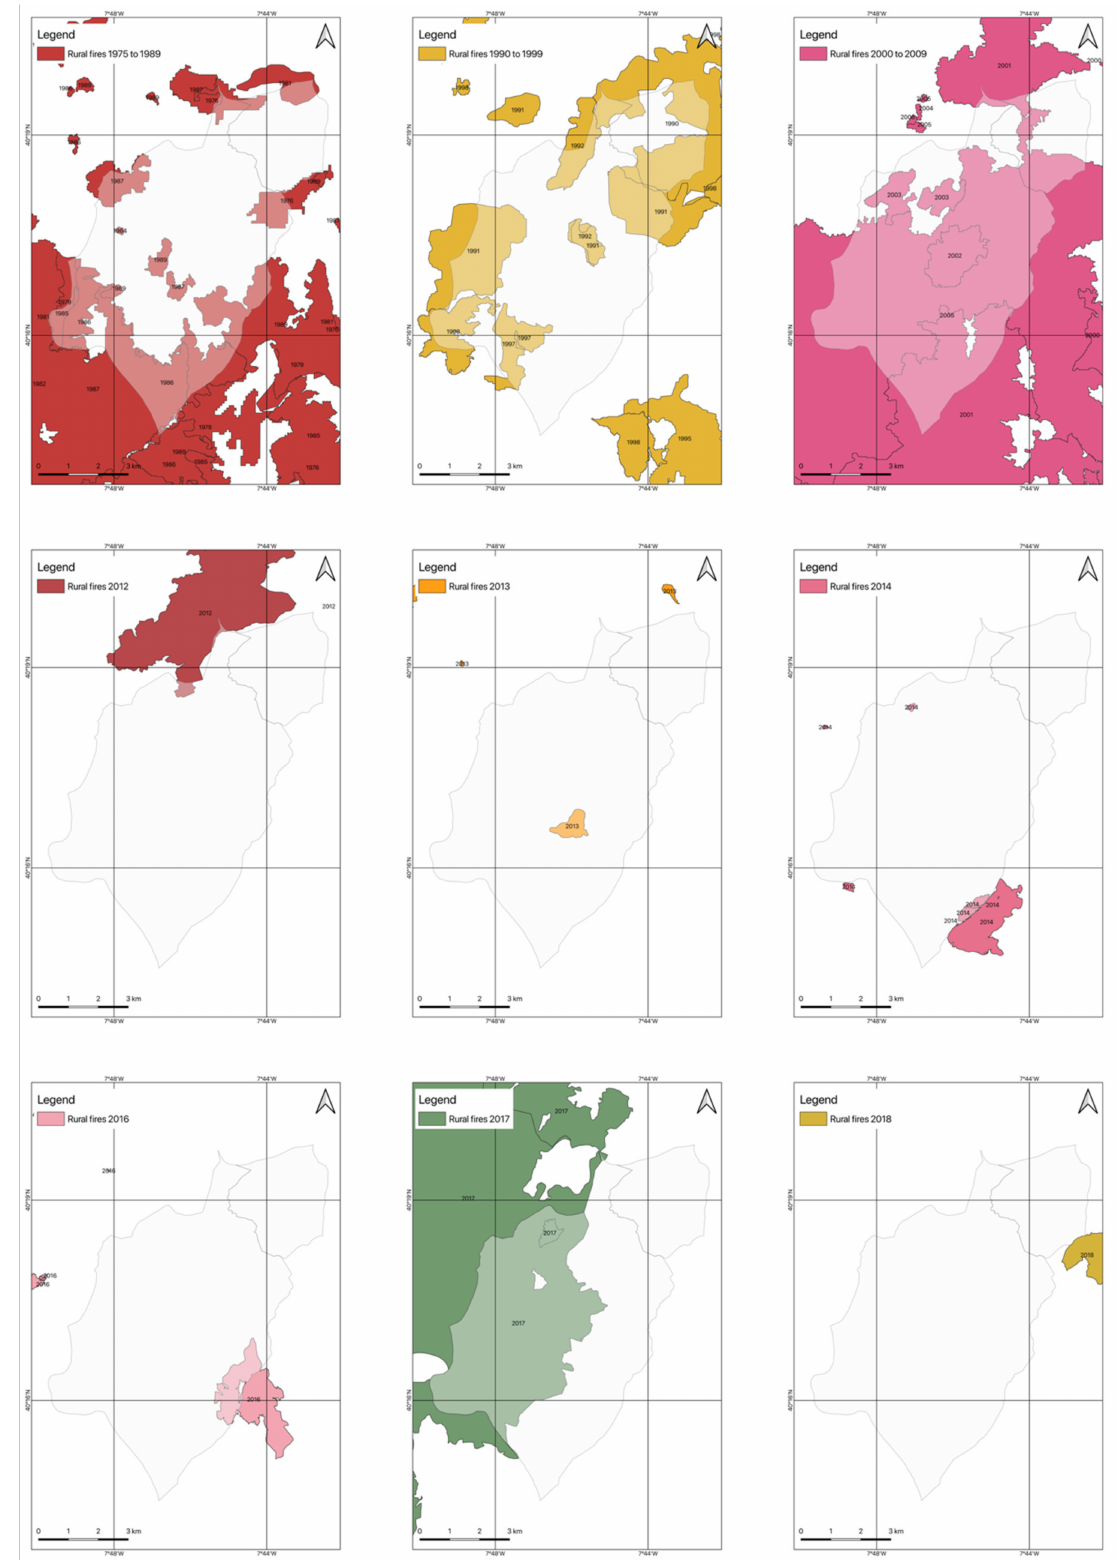
Figure 8. Burnt areas between 1975 and 2019 in Uni ã o de Freguesias de Vide e